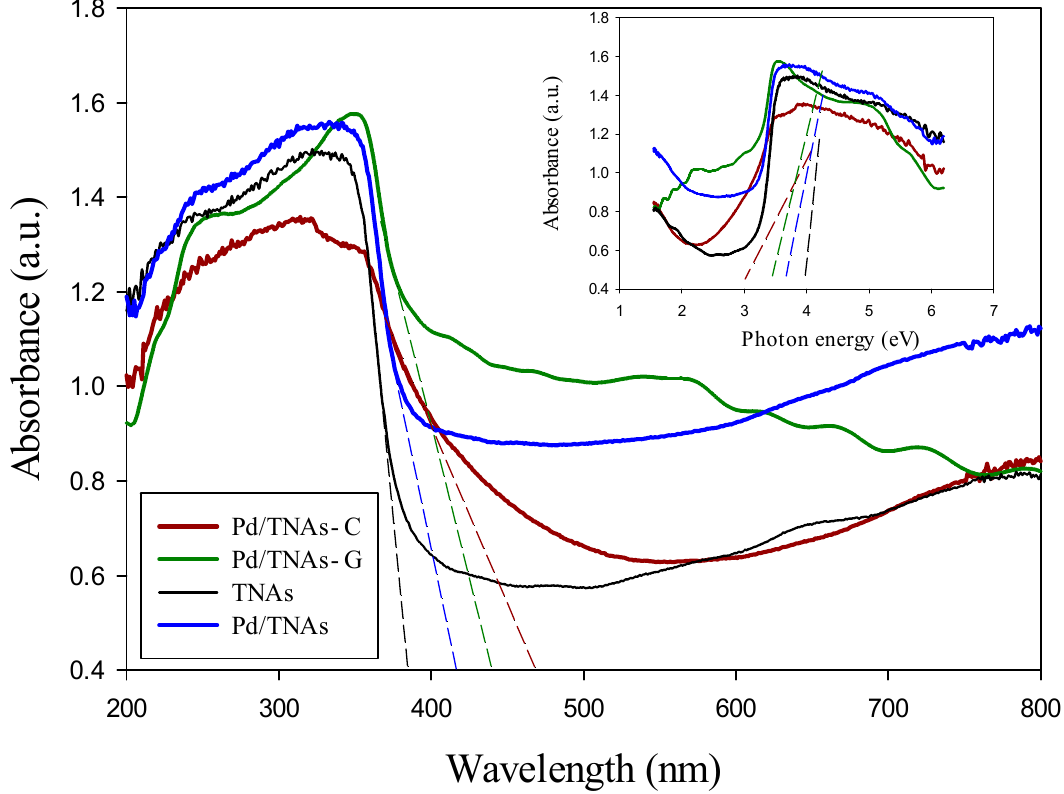
Figure 4. UV-VIS spectra of TNAs, Pd/TNAs, Pd/TNAs-C, and Pd/TNAs-G.